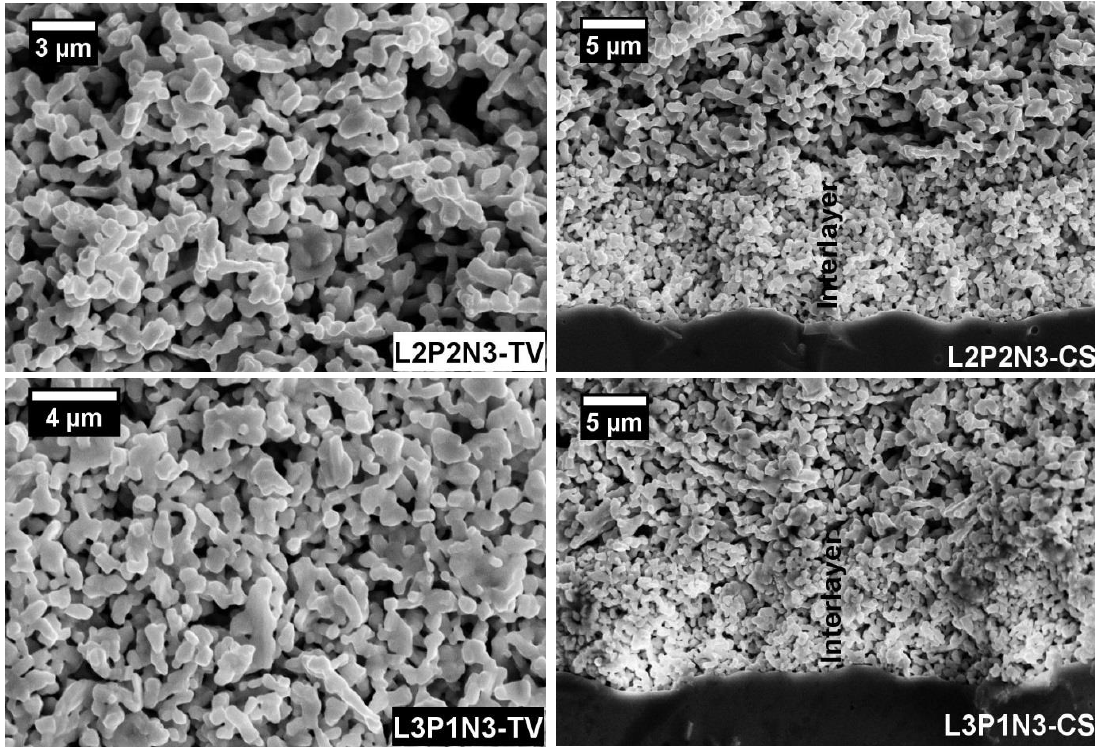
Figure 6. Post-test SEM images of single fuel cells based on L2P2N3 and L3P2N3 cathodes showing a porous cathode structure, with minor particle coarsening. The interface structure retains the integrity observed in half-cell samples.